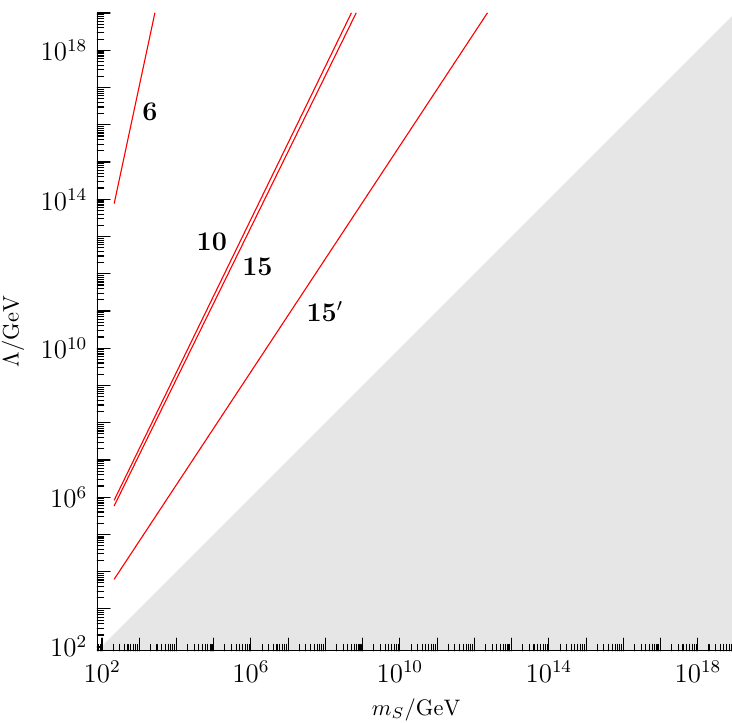
Figure 6 . Perturbativity bounds for SM extended by one coloured scalar multiplet S as a function of m S . Below m S the e(cid:11)ective theory is given by the SM (gray). The Landau poles of the 3 and 8 (not shown) are far above the Planck scale for the depicted mass